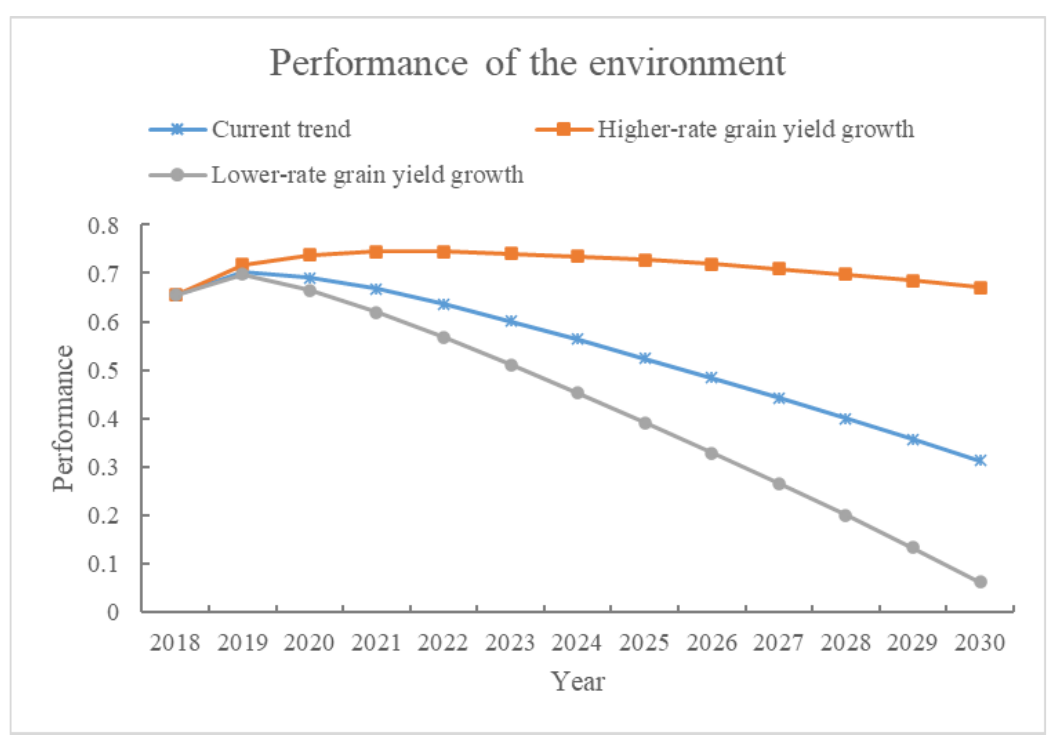
Figure 7. Performance of the environment under three scenarios.